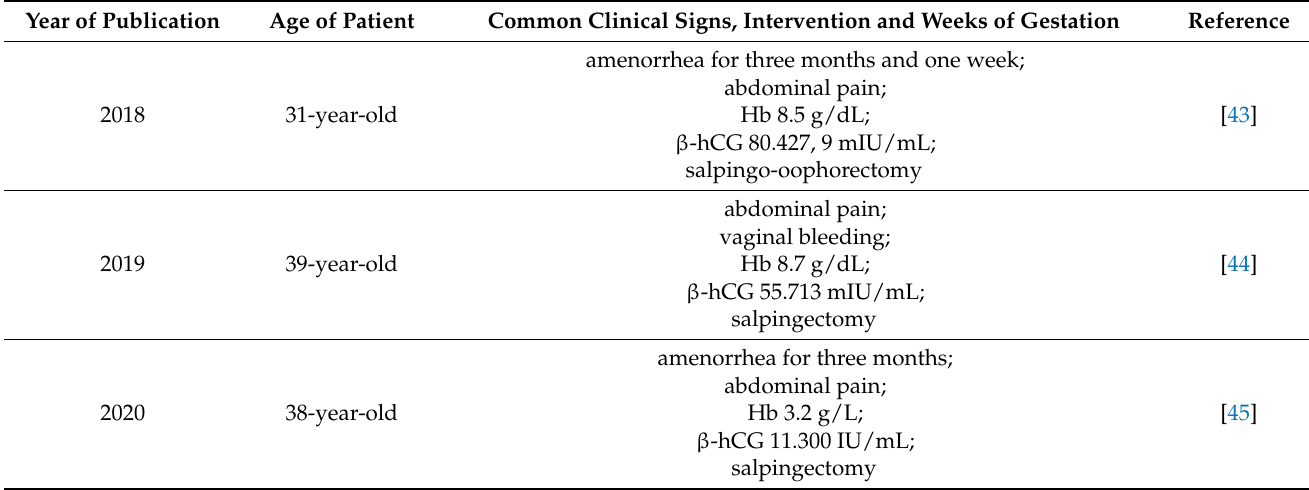
Table 1. A retrospective overview of 13-week tubal ectopic